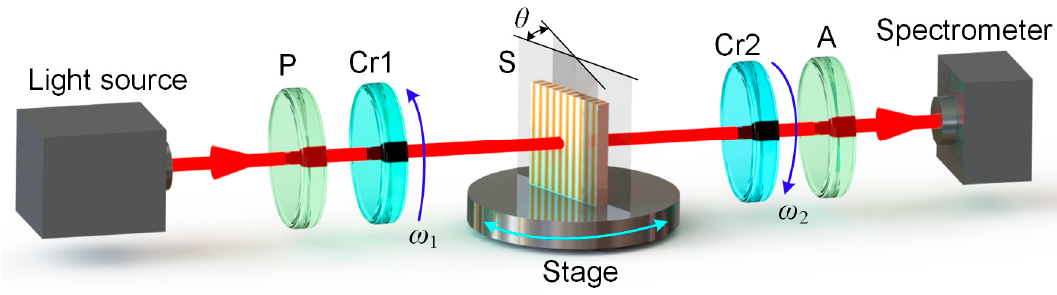
Figure 5. Scheme of the experimental setup based on a dual rotating-compensator Mueller matrix ellipsometer (MME) in the transmission mode.